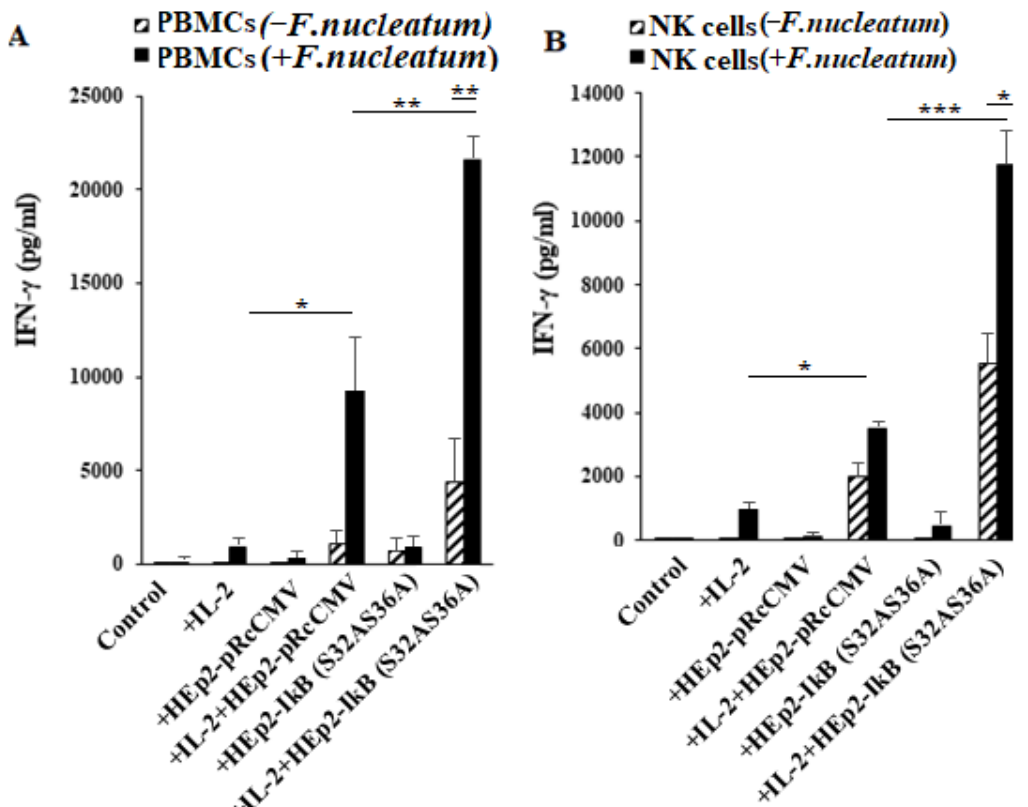
Figure 6. Increased IFN- γ secretion levels were observed in F. nucleatum treated PBMCs and NK cells; highest secretion levels were seen in the presence of NF κ B blocked HEp2 tumors. PBMCs were left untreated or treated with IL-2 (2000 U/mL) overnight before their co-culture with HEp2-pRcCMV or HEp2-I κ B(S32AS36A) cells in the presence or absence of F. nucleatum (bacteria: PBMCs: Hep2 tumors at 30:2:1 ratios). After an overnight incubation, the supernatants were harvested to determine IFN- γ secretion using multiplex cytokine array assay, one of four representative experiments are shown in the figure ( A ). NK cells were left untreated or treated with IL-2 (2000 U/mL) overnight before their co-culture with HEp2-pRcCMV or HEp2-I κ B(S32AS36A) cells in the presence or absence of F. nucleatum at (bacteria: PBMCs: Hep2 tumors at 30:2:1 ratios). After an overnight incubation, the supernatants were harvested to determine IFN- γ secretion using multiplex cytokine array assay ( B ). One of four representative experiments is shown in this figure *** ( p value < 0.001), ** ( p value 0.001–0.01), * ( p value 0.01–0.05).